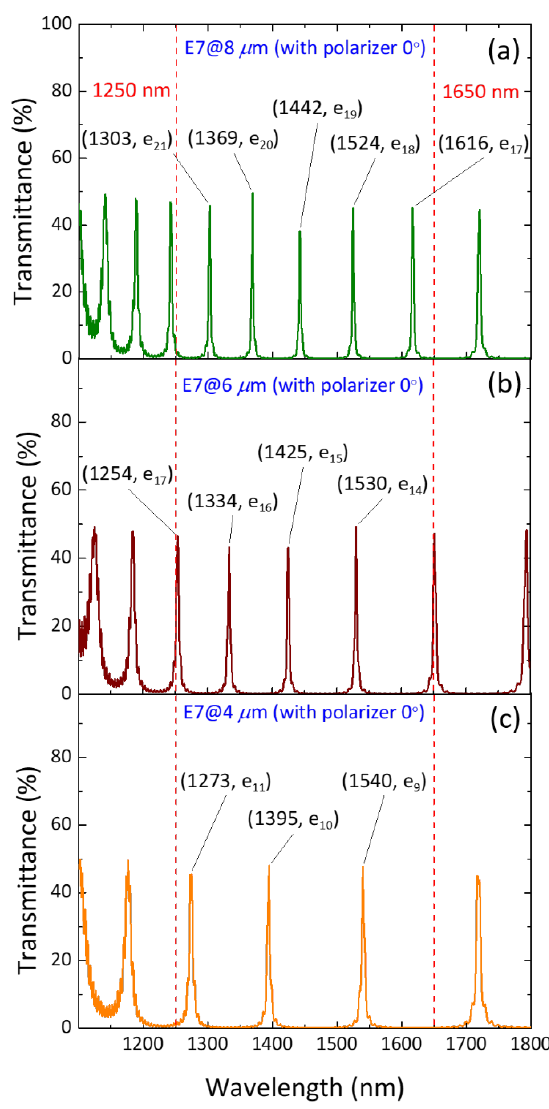
Figure 4. Simulated polarization transmission spectra of three PC/LC cells for a normally incident beam of linearly polarized light at zero voltage. The cell thicknesses considered are ( a ) 8 μm, ( b ) 6 μm, and ( c ) 4 μm. The four-digit number in a pair of parentheses specifies the wavelength in nm and the subscript m in a label e m stands for the order of an e -wave resonance in the microcavity.